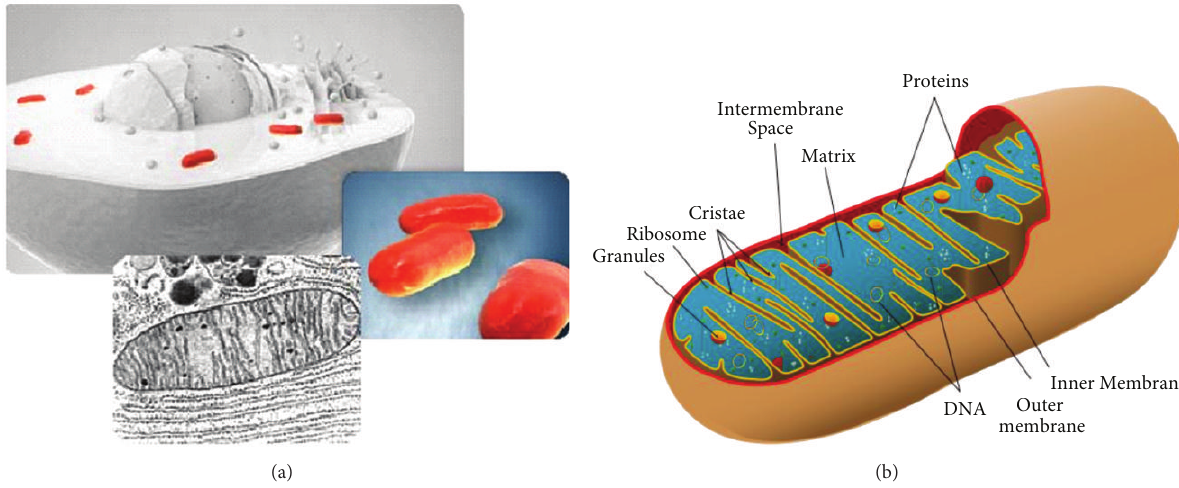
Figure 8: Mitochondrial inner membrane cristae (a) 3D illustration upper left shows spheroidal mitochondria in red located peripherally circumferential around the nucleus and SEM below showing convoluted cristae. (b) Mitochondrion illustration with tortuous cristae ((a) with permission from the National Institutes of Health/Department of Health and Human